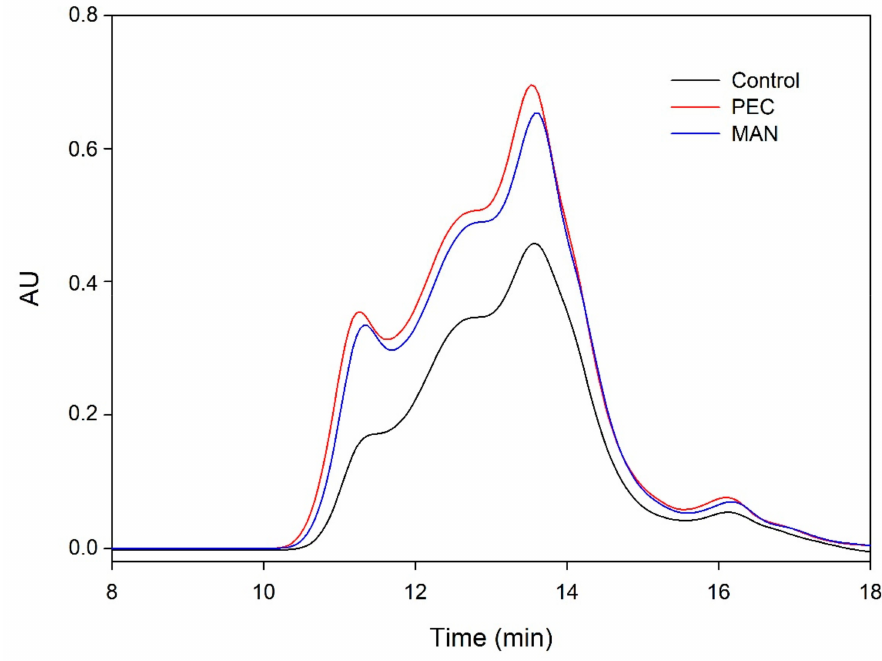
Figure 9. Mass distribution of the proanthocyanidins of the final wines analyzed by SEC at the end of alcoholic